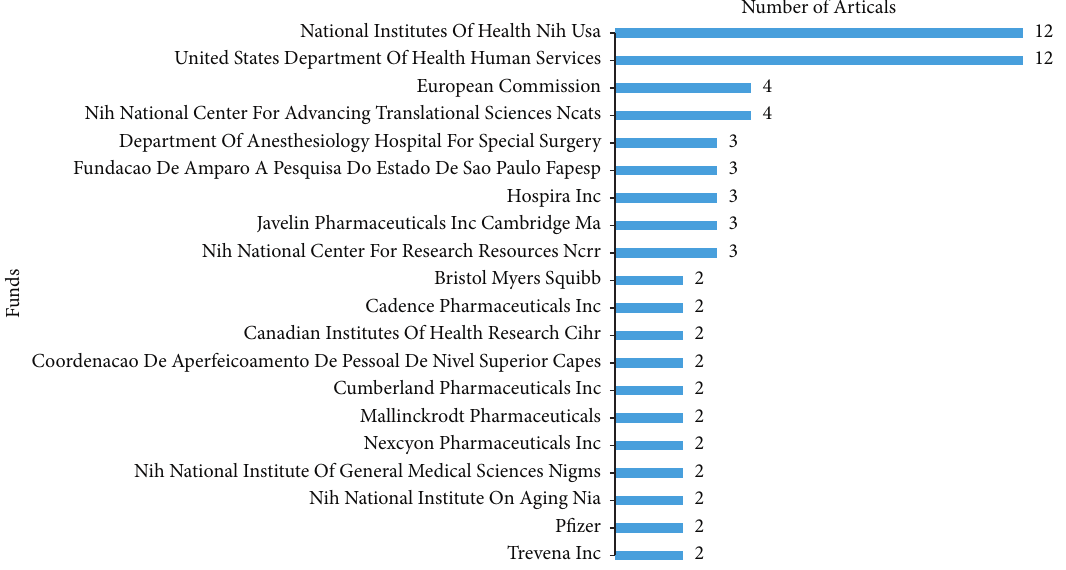
Figure 4: Top 20 funds for the most publications on analgesics in the treatment of orthopedic postoperative pain.